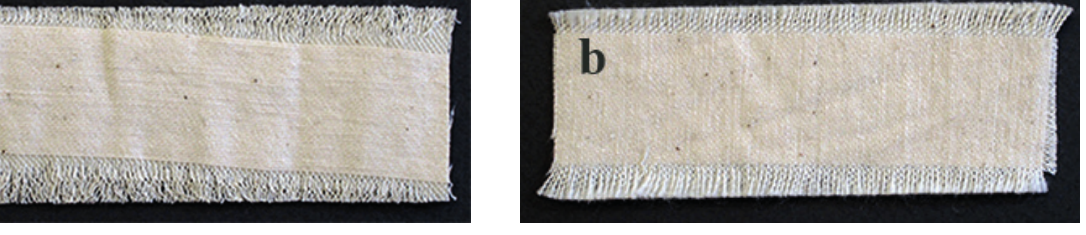
Figure 1 - Photographs of warp ( a ) and wept ( b ) control samples.